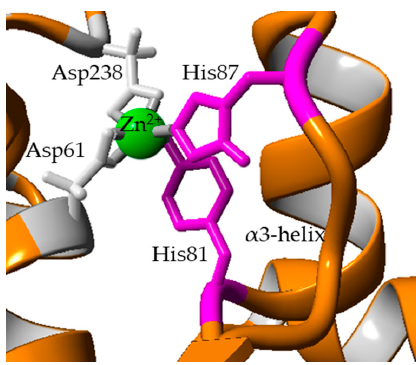
Figure 5. The Zn 2+ binding domain by residues His81 and His87 (magenta) of the α 3-helix. Shown in grey are Asp61 and Asp238, the other 2 residues in Zn 2+ binding.